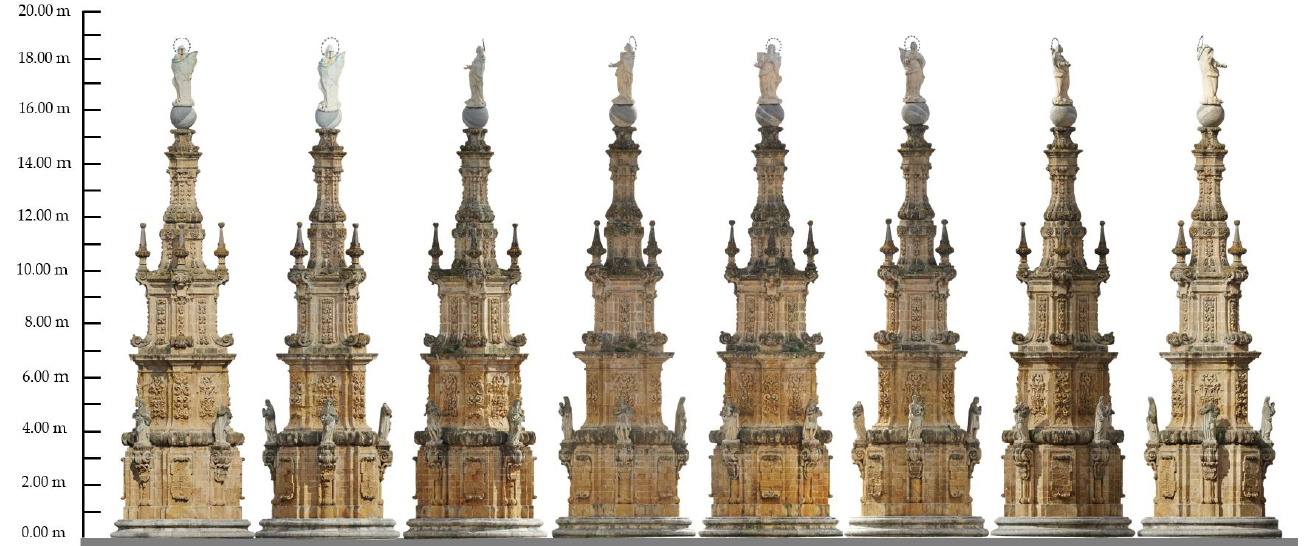
Figure 10. Several orthophotos of the spire generated from the 3D